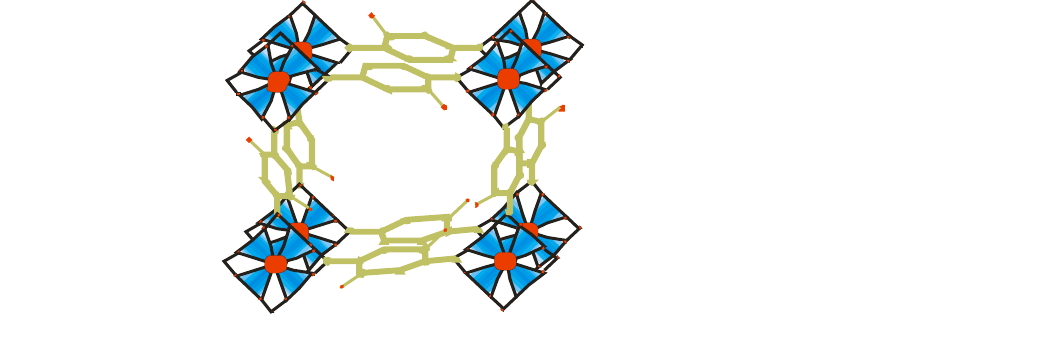
Figure 13. Representation of the structure of IRMOF-1 and IRMOF-2-X.